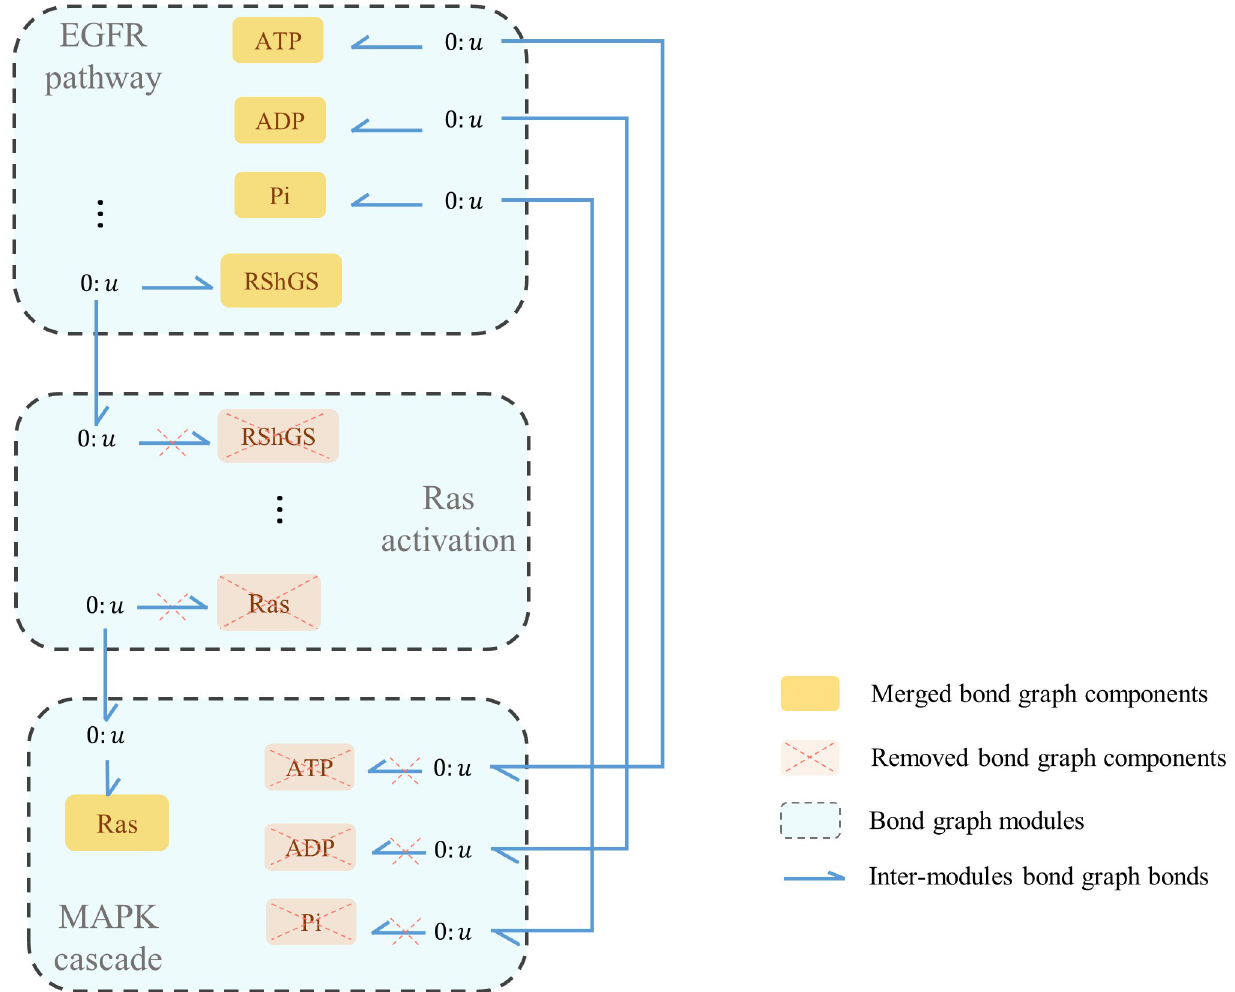
Fig 10. The composed modular bond graph model of EGFR-Ras-MAPK signalling pathway. The blue dashed boxes represent the bond graph modules, the yellow boxes show the merged common components between the modules (each sharing a common potential by a ‘0: u ’ junction), and the blue harpoons represent the bonds between the modules and common components. The inter-module bonds, along with the internal bonds between the components in each module, are defined and automatically applied to the model using the whole connectivity matrix. The EGFR and MAPK cycles also share common potentials with C :ATP, C :ADP, and C S S S